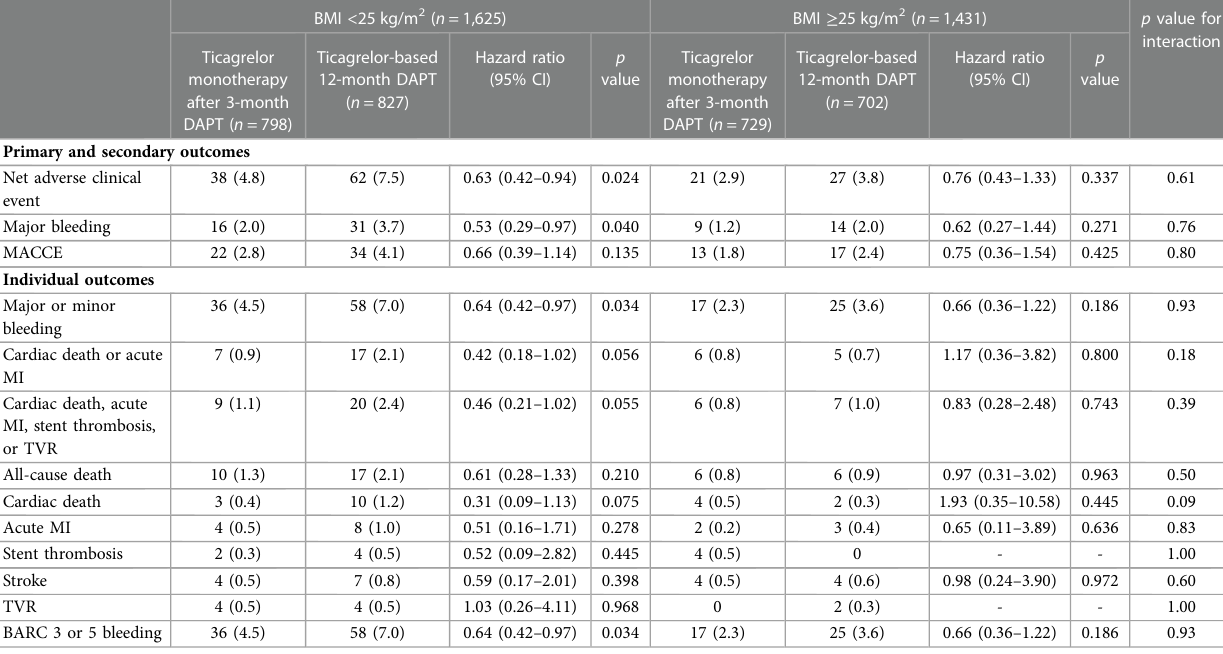
TABLE 2 Clinical outcomes according to the pre-speci fi ed BMI groups and antiplatelet strategy at 12 months follow-up. BMI <25 kg/m 2 ( n